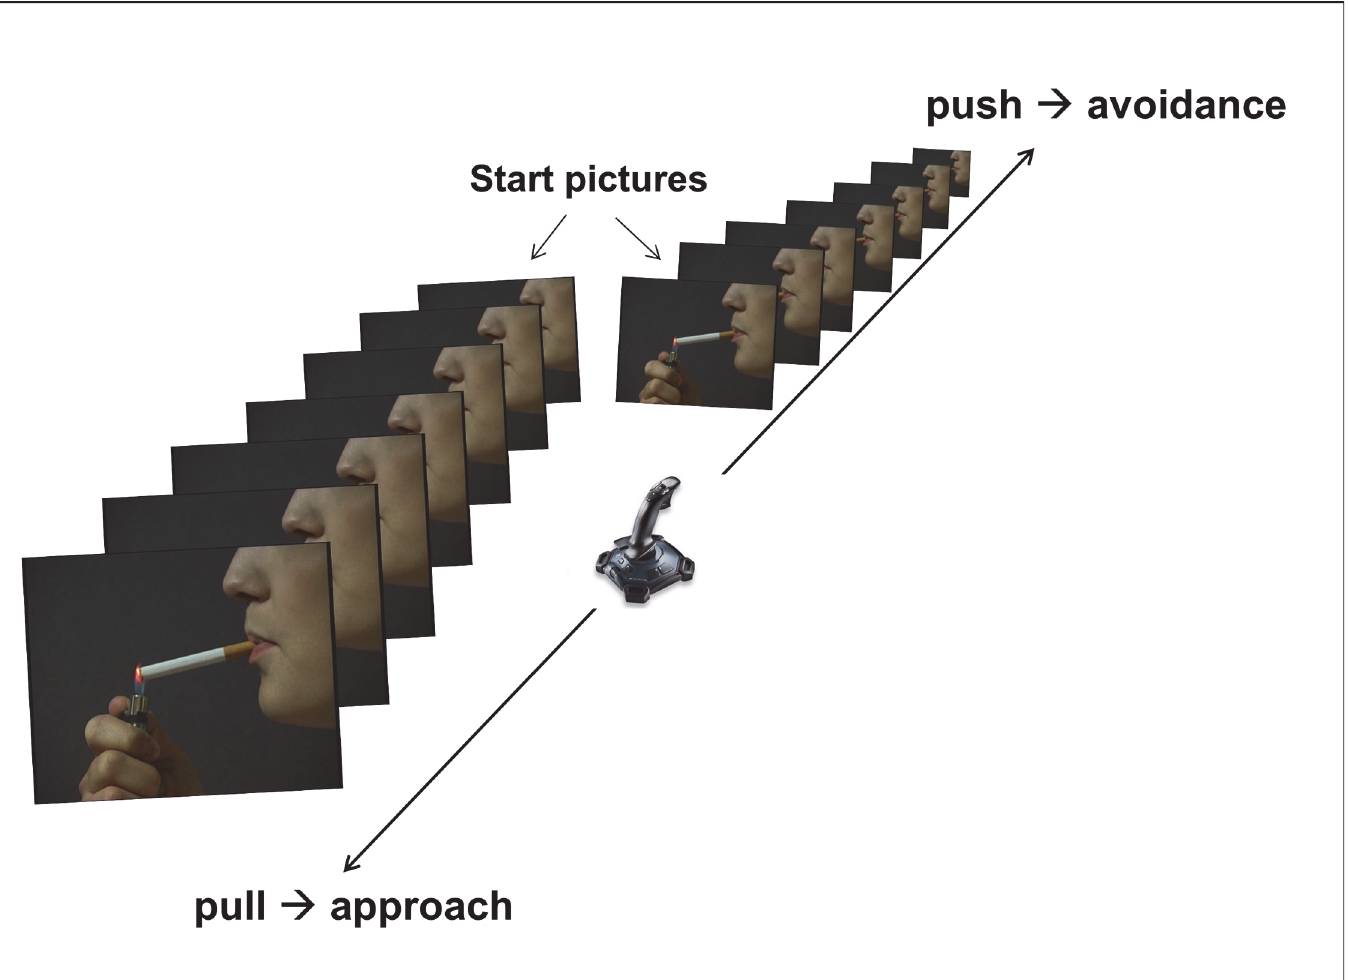
Figure 1. Schematic demonstration of the trials used in the AAT for nicotine-related pictures. Pulling the joystick increases the picture size, while pushing the joystick decreases the picture